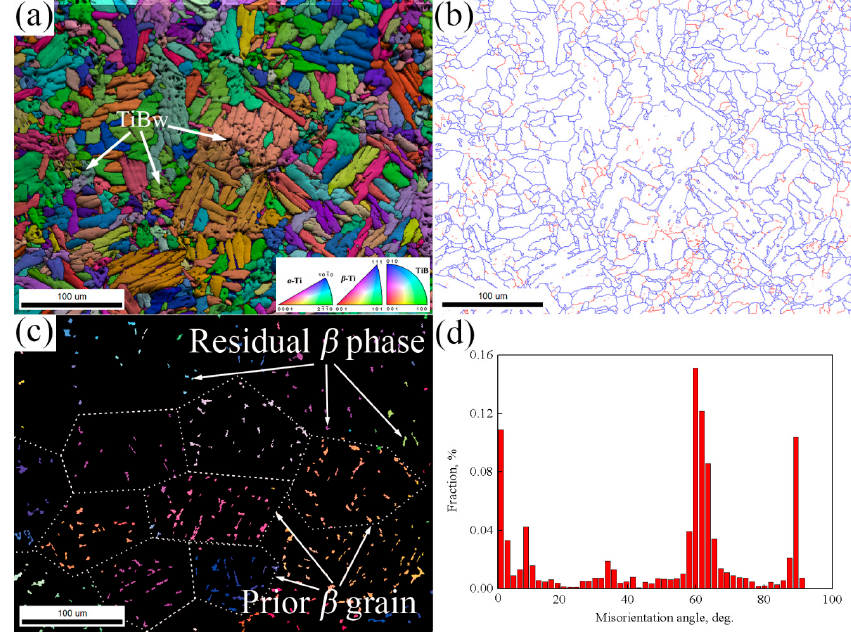
Figure 5. EBSD results of 2.5 vol % TiBw/TA15: ( a ) IPF + IQ + GB; ( b ) EBSD results showing the LAGBs (red lines, 2°–15 ° ) and HAGBs (blue lines, 15°–180 ° ); ( c ) residual β phase; ( d ) misorientation angle of α -Ti. Table 4. The ratio of 10 ° , 60 ° , 63 ° , and 90 ° and their theoretical calculation ratios. Angle of α / α Boundary in a Parent β grain, ° (Tol ± 1°)